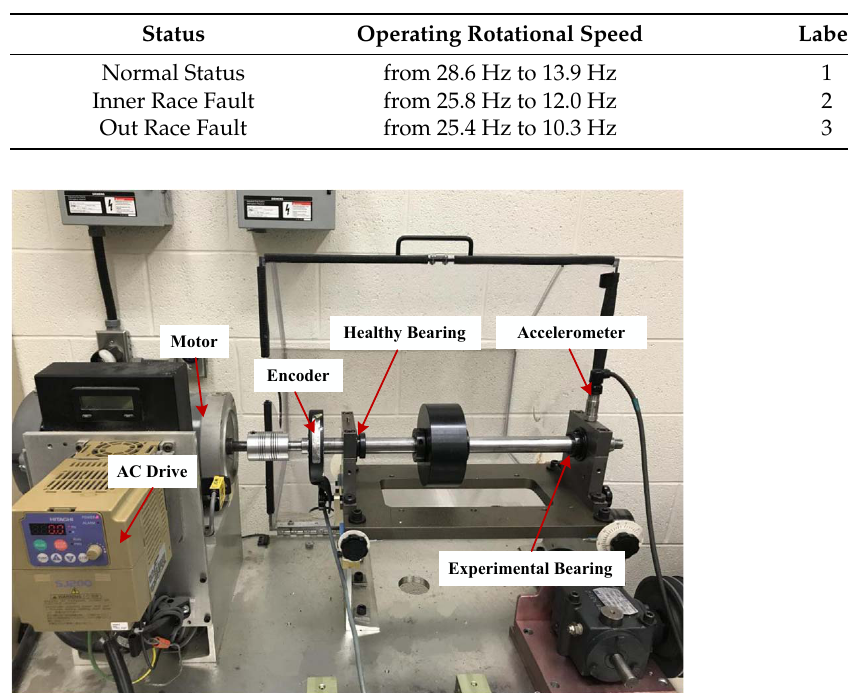
Table 1. Each Fault State and Corresponding Label in the Data Set.